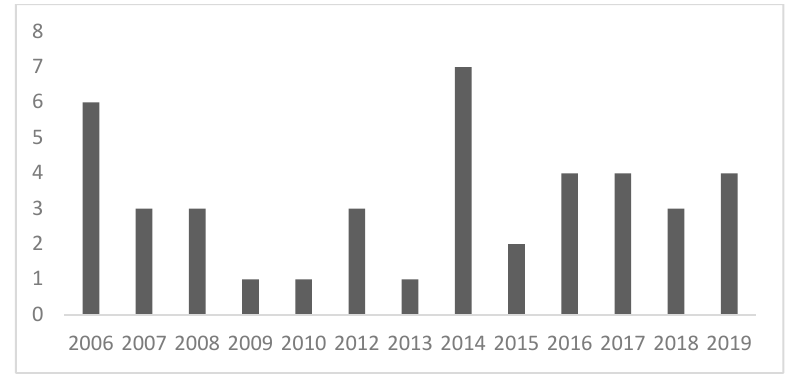
Figure 2. Number of records per year ( n = 42).